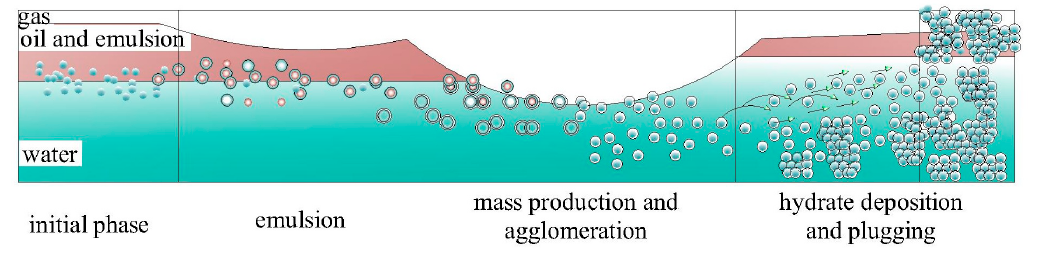
Figure 12. Schematic diagram of plugging mechanism at high water cut